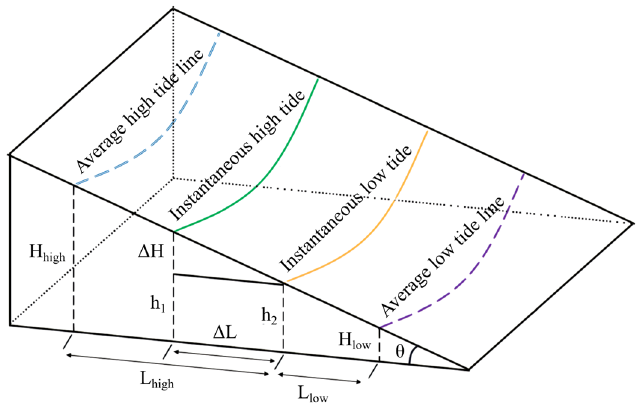
Figure 3. Instantaneous water-edge line extraction process. ( a ) Water edge image to be extracted. ( b ) MNDWI Index. ( c ) Threshold segmentation binarization. ( d ) Instantaneous water edge extraction.